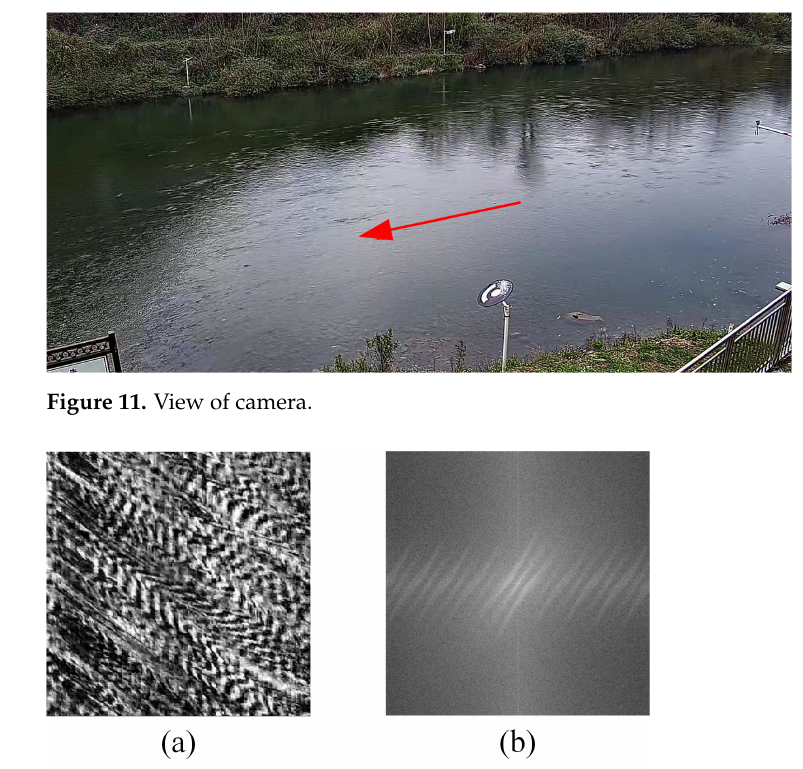
Figure 12. Example of real STI. ( a ) A STI generated from video, ( b ) The FFT image of ( a ).